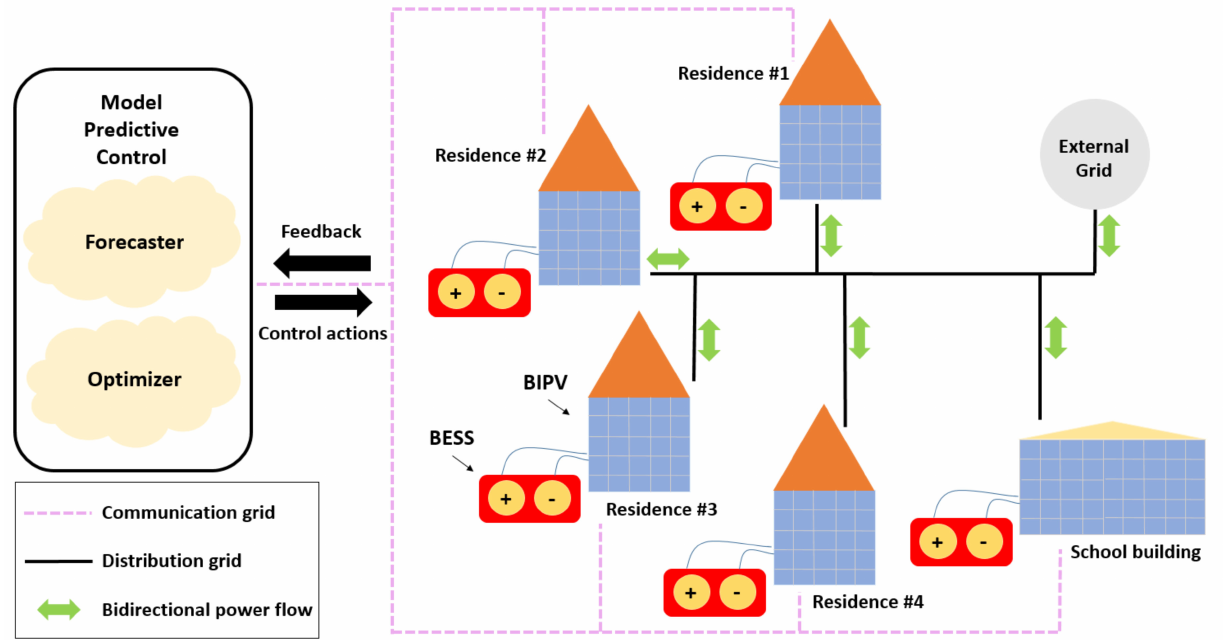
Figure 1. Schematic representation of the overall